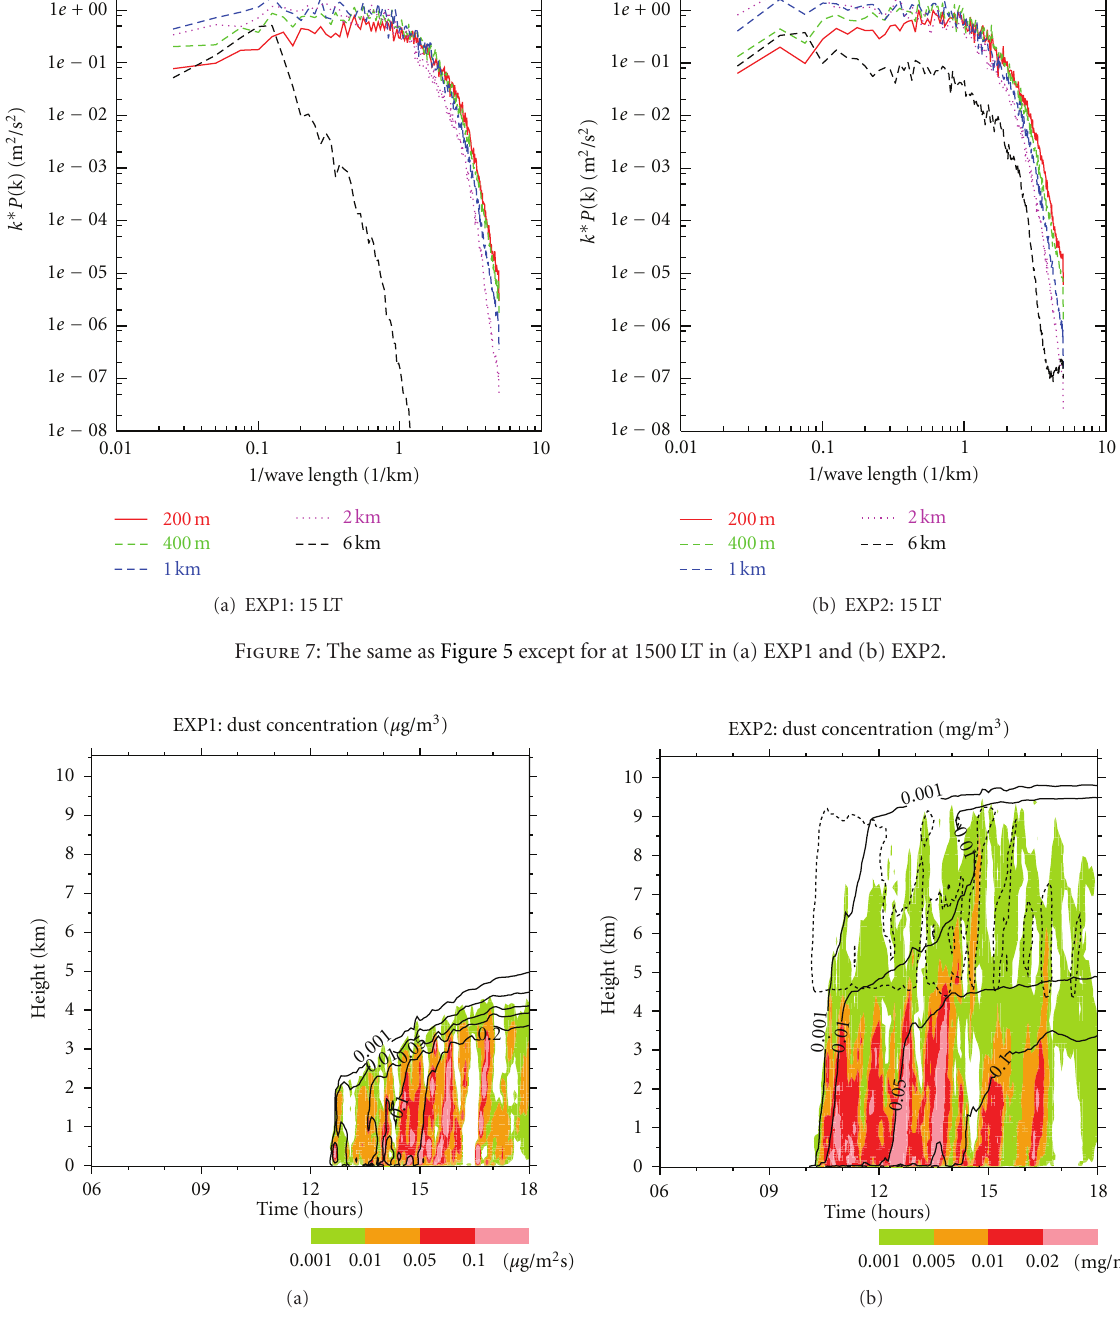
Figure 8: Time-height section of dust concentration (contoured) and vertical flux of dust (shaded, in µ gm − 2 s − 1 ) averaged over each height for (a) EXP1 and (b) EXP2. The contour intervals are (a) at 0.001, 0.01, 0.05, 0.1, and 0.2 µ g m − 3 and (b) at 0.001, 0.01, 0.05, and 0.1 mgm − 3 . In (b) the cloud boundary is indicated by broken lines as a contour of cloud mixing ratio of 0.025 gkg − 1 . increase of the dust content in the 4-km resolution case words, the poorly resolved behavior of convective motions is accomplished only within one hour during 1400 and leads to undesirable representation of dust transport under 1500 LT. This di ff erence in the temporal evolution of the 4 km convective conditions. resolution case is due to the lack of proper representations of The present study indicates that such dependence on shallow and deep convection. Actually, the 4 km resolution is horizontal resolution is closely related to the represented not su ffi ciently fine to resolve convective motions. In other spatial scales of convective motion in numerical